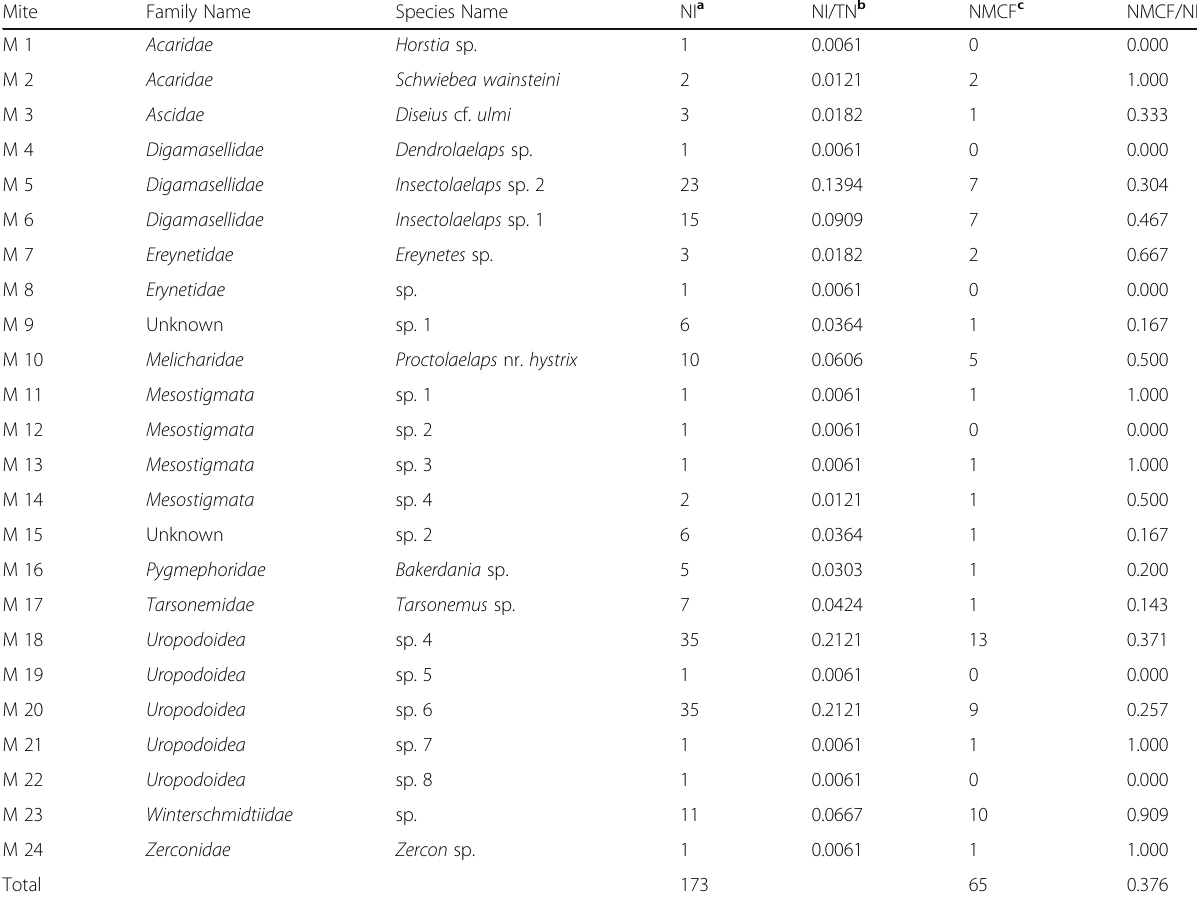
Table 1 Mites ( Acari ) collected from bark beetle galleries on spruce in Qinghai in this study